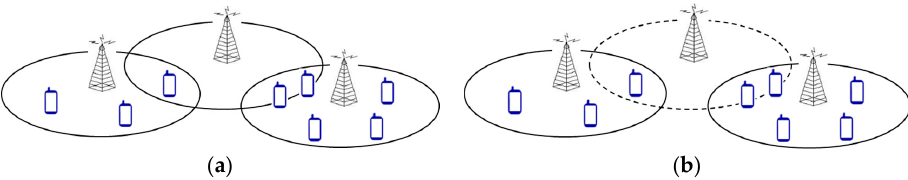
Figure 1. Activation and deactivation of base stations (BSs). ( a ) Activation; ( b ) deactivation.